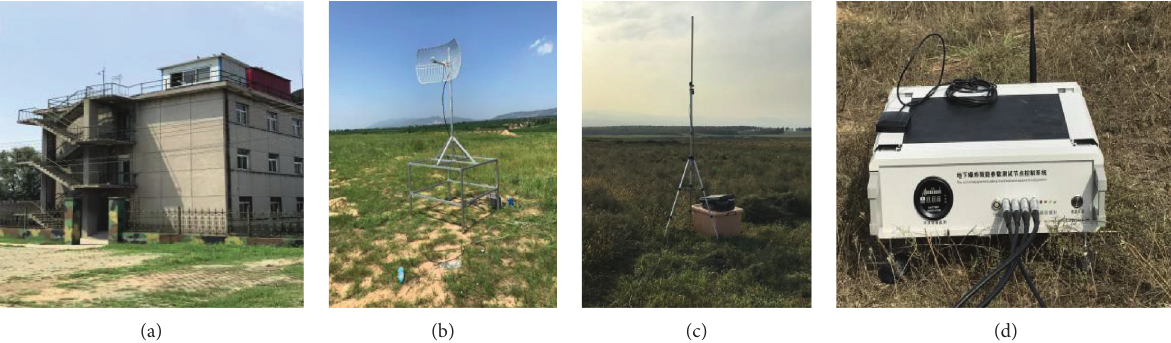
Figure 17: Field layout of the control distance of the wireless sensor nodes. (a) Main control station. (b) Field transmitting antenna. (c) Wireless APs. (d) Wireless sensor